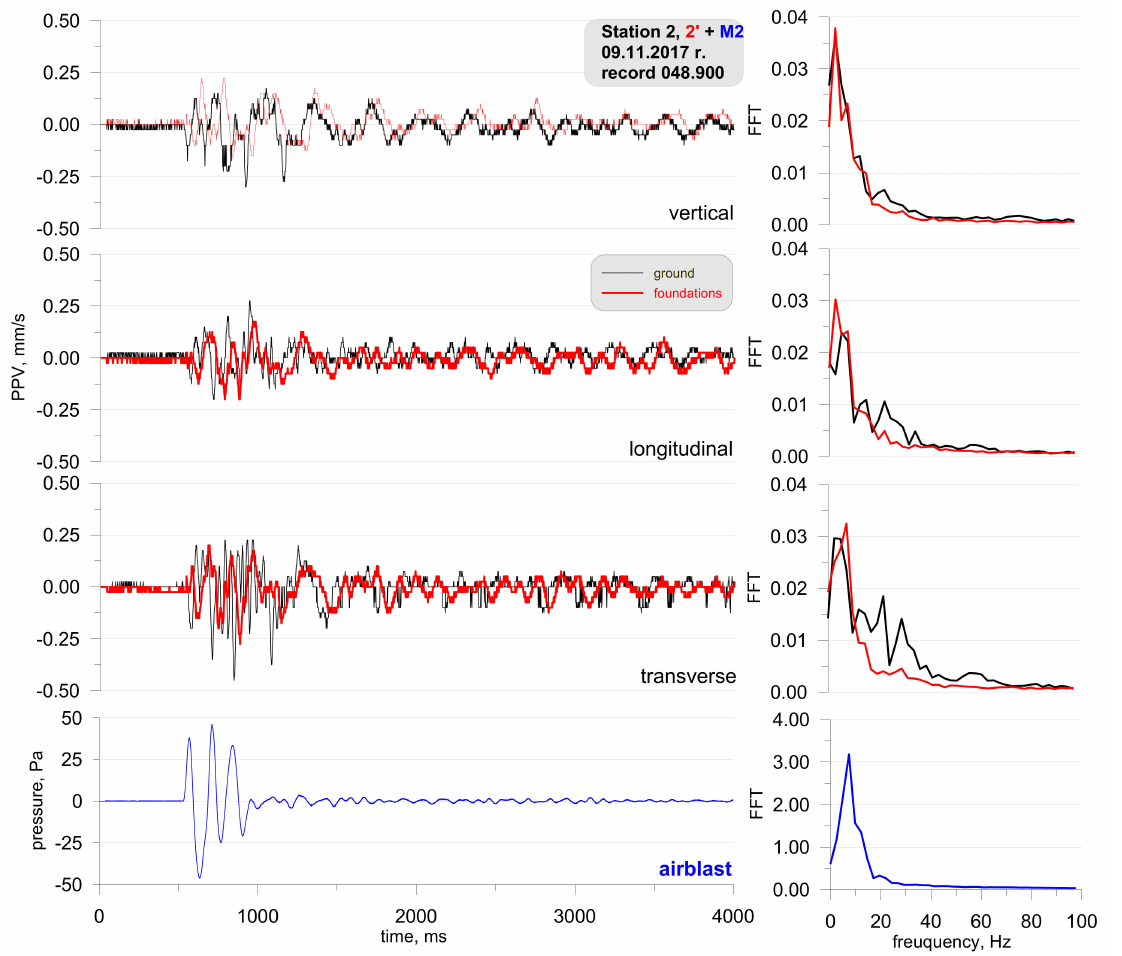
Figure 11. Seismogram of the vibration of the ground (three directional components), foundation, and record of airblast wave pressure together with the analysis of the FFT-Station